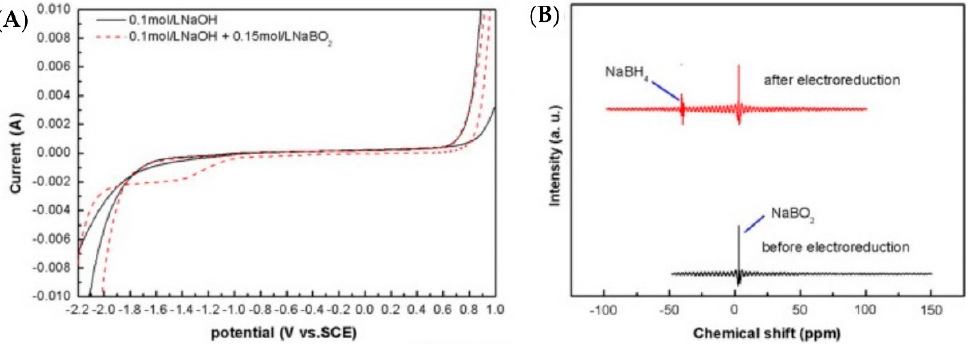
Figure 5. ( A ) Cyclic voltammogram of a BDD electrode in 0.1 M NaOH and 0.1 M NaOH + 0.15 M NaBO 2 at 0.100 V s − 1 ; and ( B ) 11 boron NMR spectrogram of electrolytes before and after electrore- duction, reaction conditions: 1.5 V forward pulse voltage, 0.3 V reverse pulse voltage, 1.5 s forward pulse duration, 0.5 s reverse pulse duration, 0.15 M NaBO 2 concentration, 0.1 M NaOH, 1.5 h of